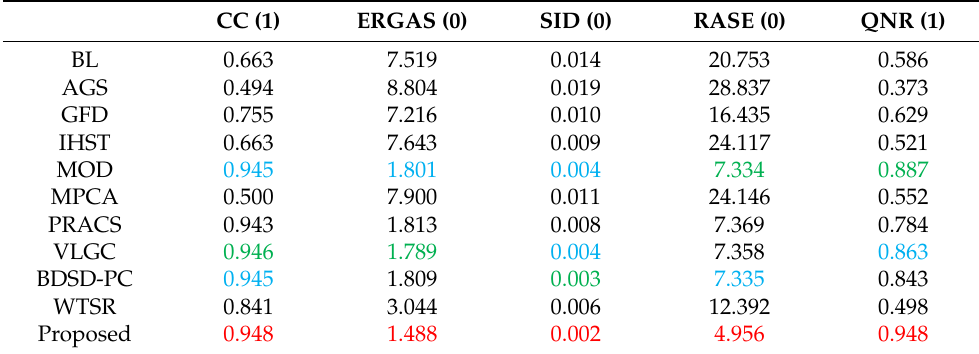
Table 1. The first group of quantitative